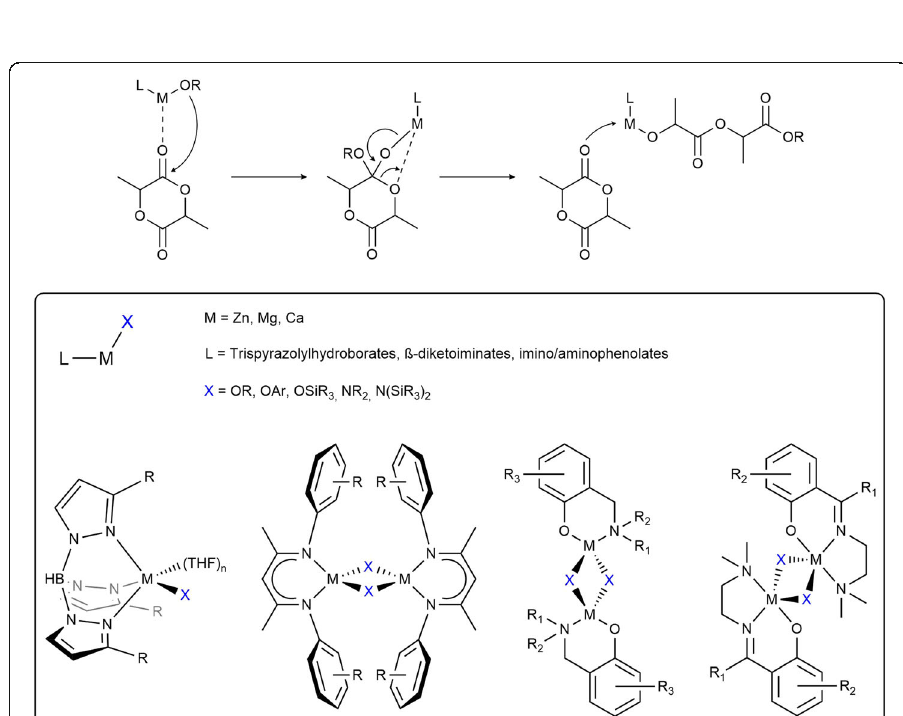
Fig. 4 ROP of lactide (top), single-site initiators used in ROP of cyclic esters